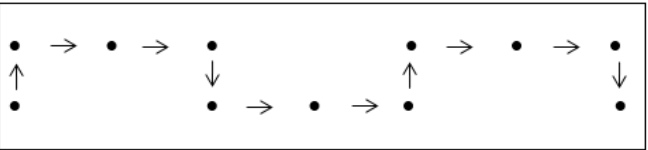
Figure 6. NSE lattice walk: NEESEENEES of length 10 and height 0.